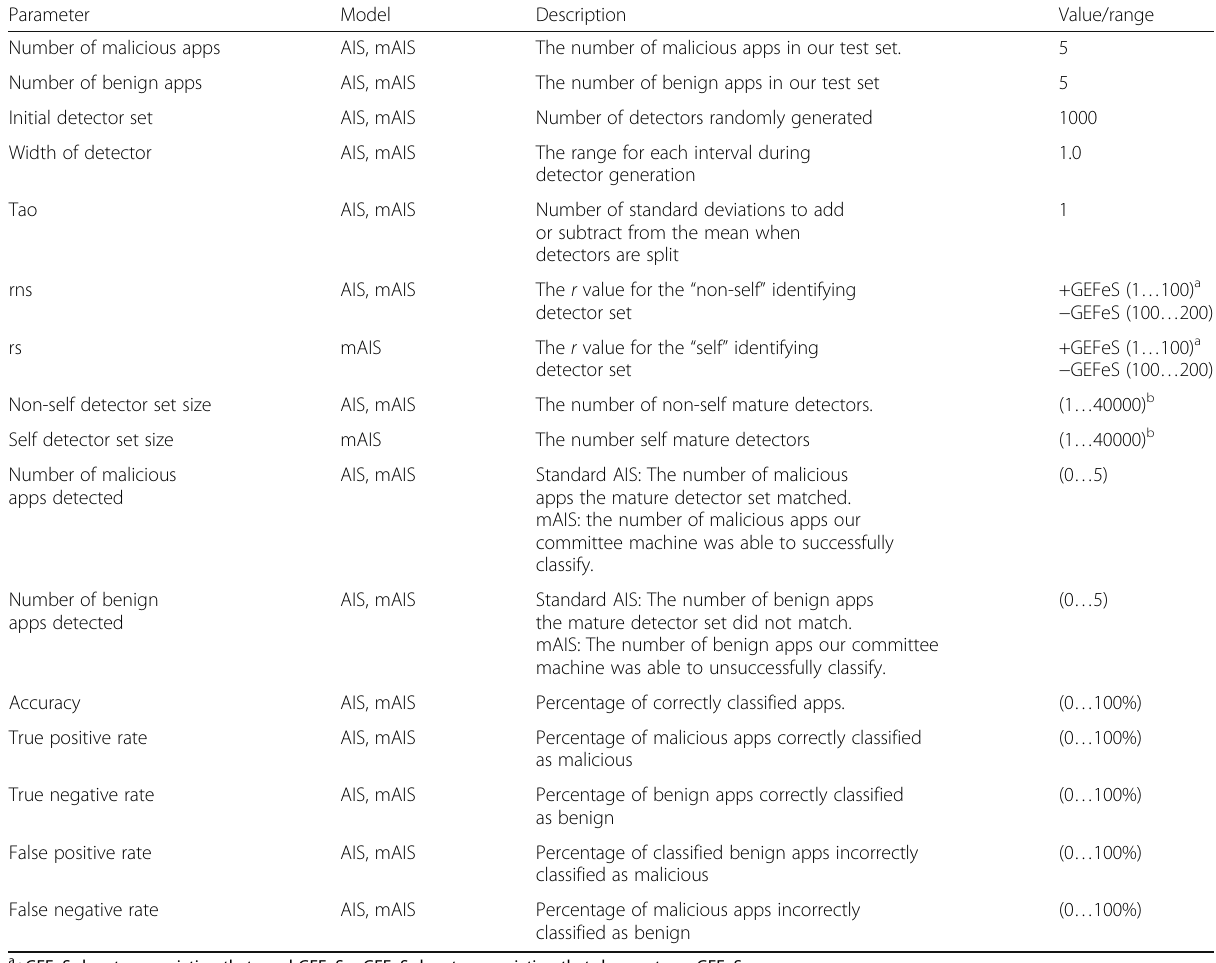
Table 1 Parameters used for AIS and mAIS